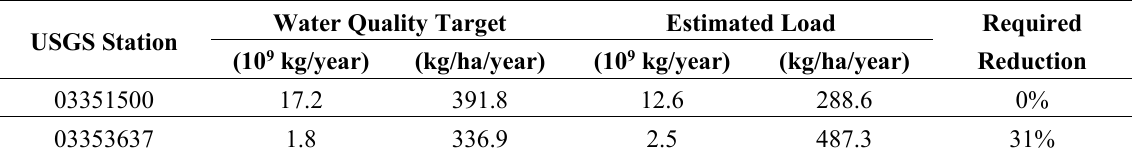
Table 2. Target and estimated annual sediment